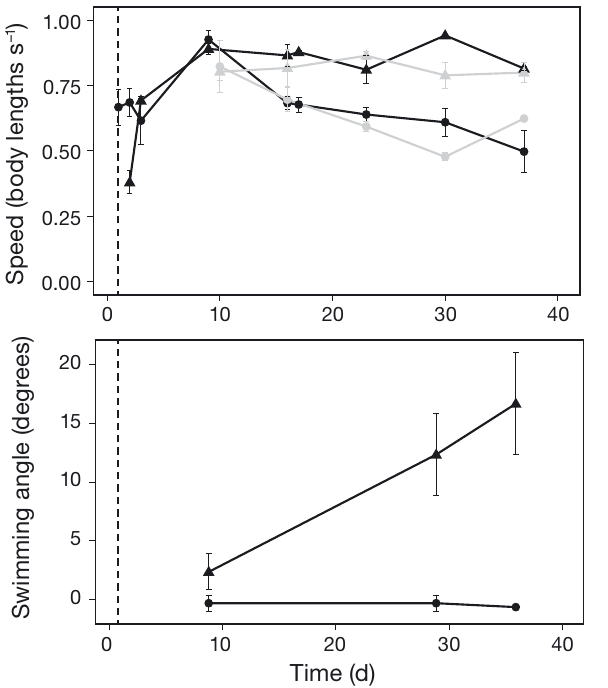
Table 1. Output from repeated-measures ANOVA of linear models with treatment (control or submerged